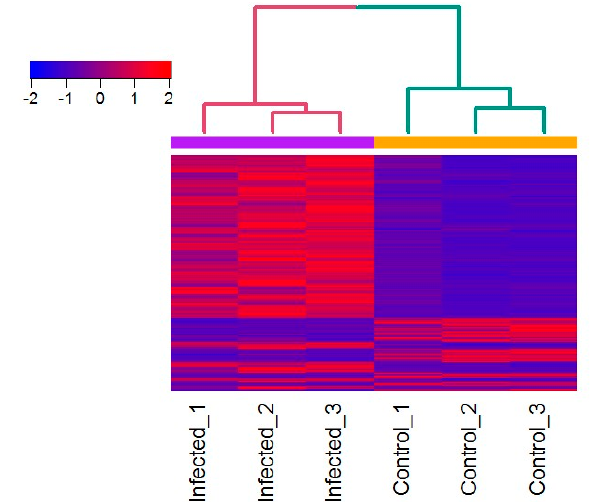
Figure 4. Heatmap showing the expression patterns of genes in the zooid samples. Heatmap of Z scaled RNA-seq normalized TPM values of 1166 differentially expressed transcripts (FDR adjusted p -value: ≤ 0.01) among the infected and uninfected control zooids. Red indicates upregulation; blue indicates downregulation, as indicated in the color key. Each row represents one gene and each column represents an individual zooid. Euclidean distance and complete linkage method was used for hierarchical clustering.